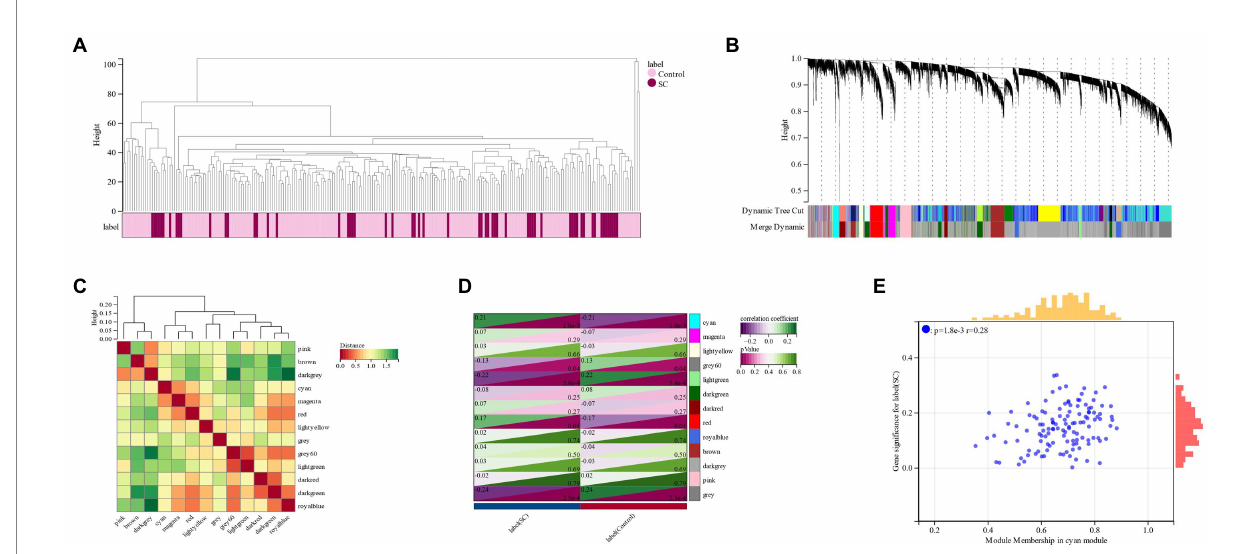
FIGURE 2 (A) The Clustered tree diagram of schizophrenia and its control group; (B,C) : Schizophrenia gene co-expression module (GCM); (D) : Correlation between schizophrenia and GCM; (E) : The correlation between module members and gene significance in the Cyan module of